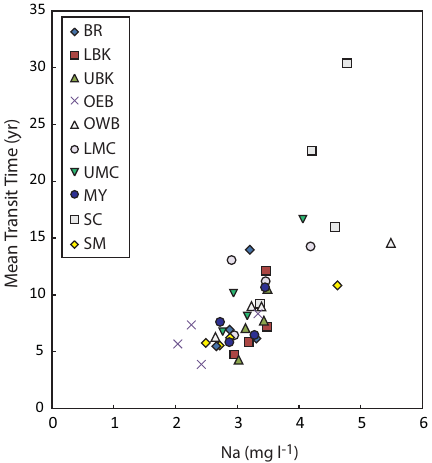
Figure 9. Mean transit times calculated using the Exponential- Piston Flow model vs. Na concentrations for the sites in the Ovens catchment (data from Tables 1 and 2). There is a broad correlation between mean transit time and Na con- centration. BR = Bright, LBK = Lower Buckland, LMC = Lower Morses Creek, MY = Myrtleford, OEB = Ovens East Branch, OWB = Ovens West Branch, SC = Simmons Creek, SM = Smoko, UBK = Upper Buckland, UMC = Upper Morses